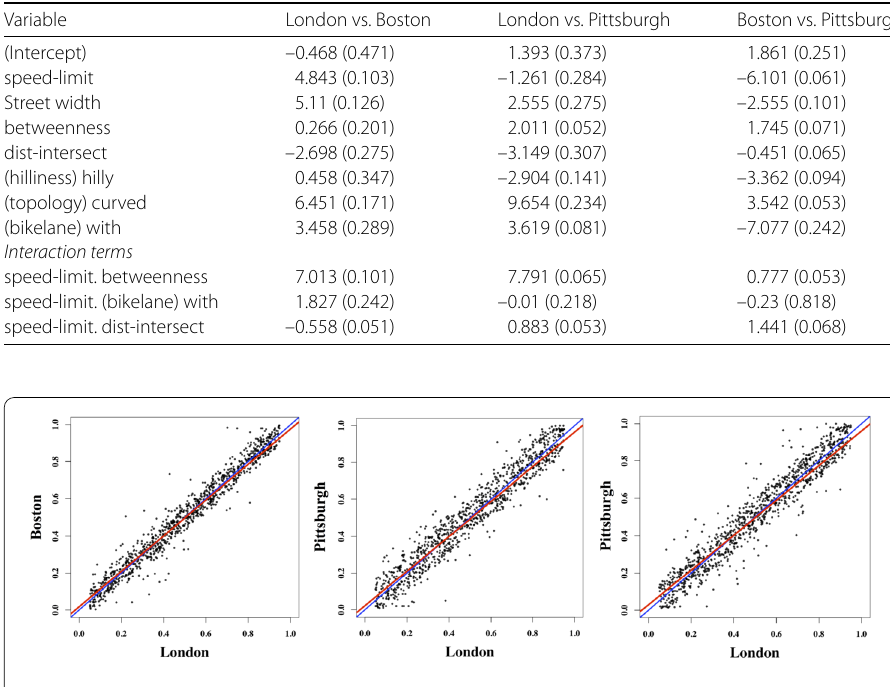
Figure 2 Severe accident probability for 1000 random locations in San Francisco as estimated from all three different risk models. All models provide similar probabilities for the same